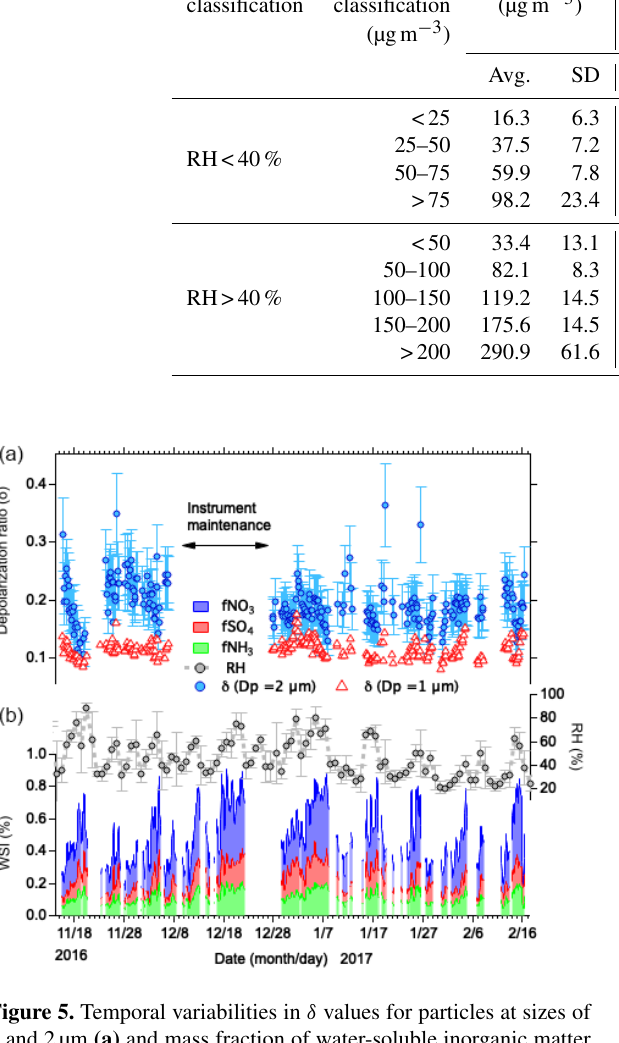
Table 1. The relationship between f NO 3 /c NO 3 , f SO 4 /c SO 4 and mass concentration of PM 2 . 5 at different RH conditions. RH PM 2 . 5